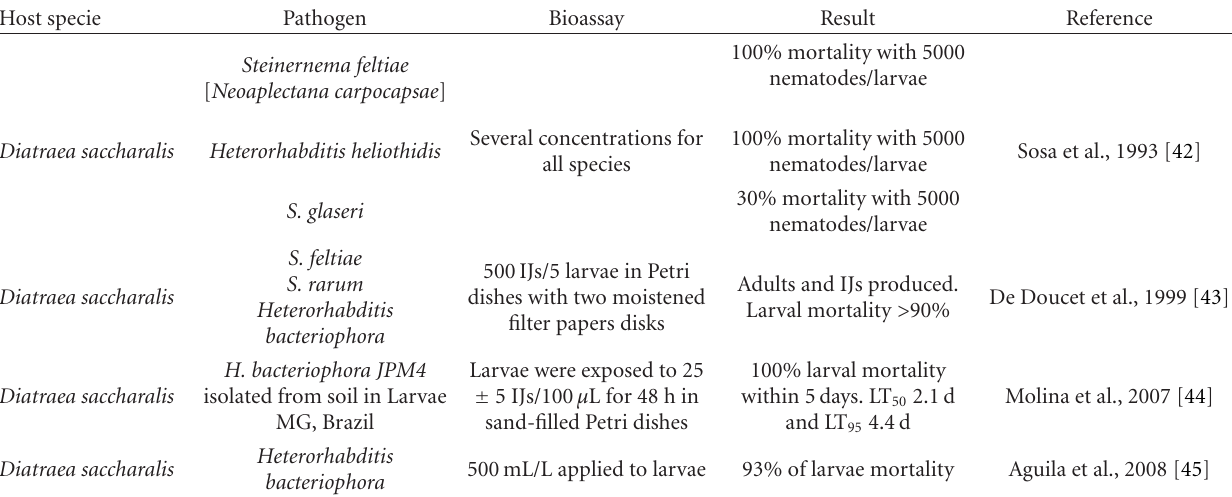
Table 4: Entomopathogenic-nematode bioassays on Diatraea